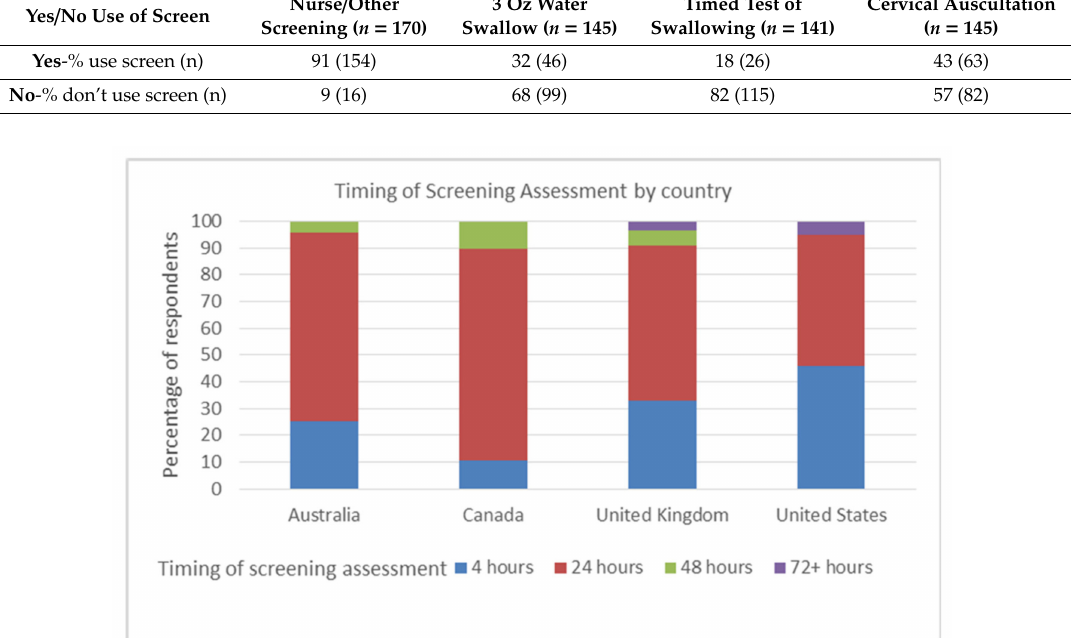
Figure 1. Time elapsed before the screening assessments conducted by each